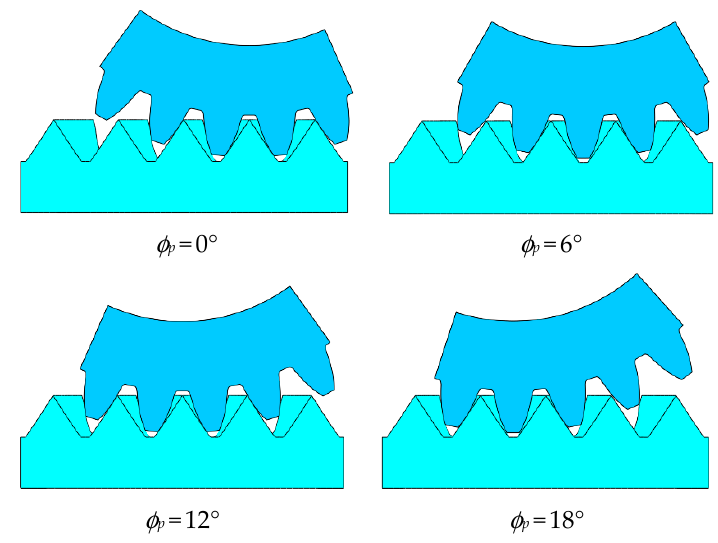
Figure 12. Modeling of the proposed face gear pair.